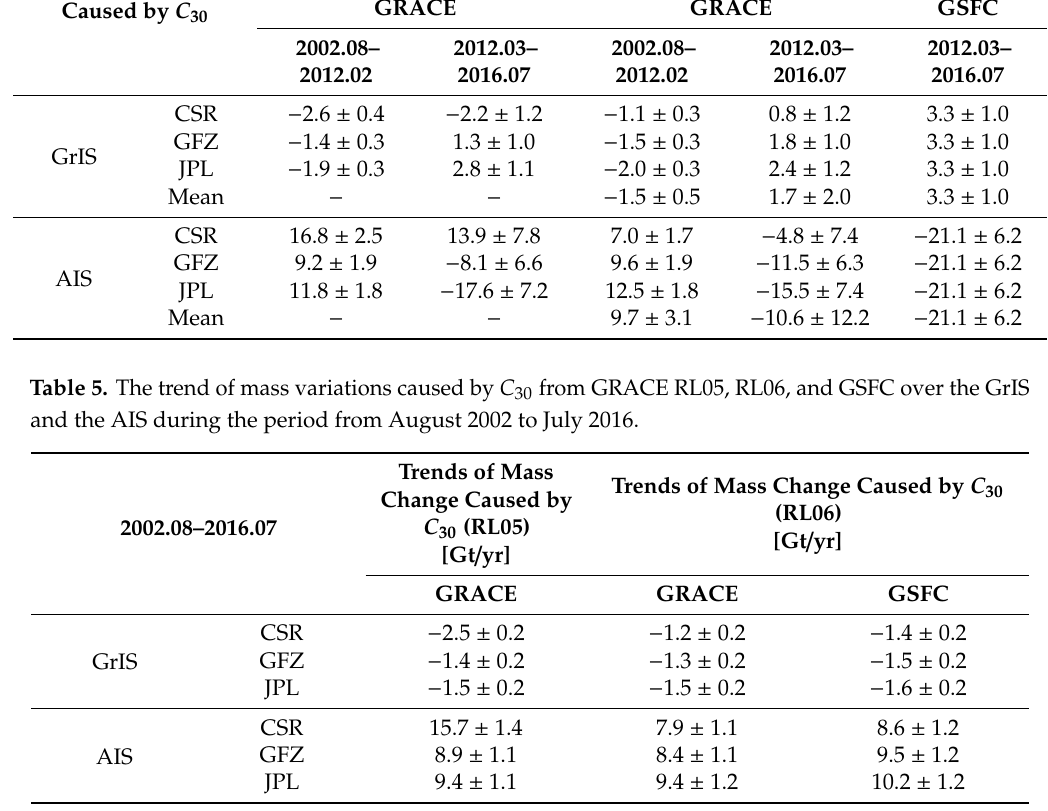
Mass Change Caused by C 30